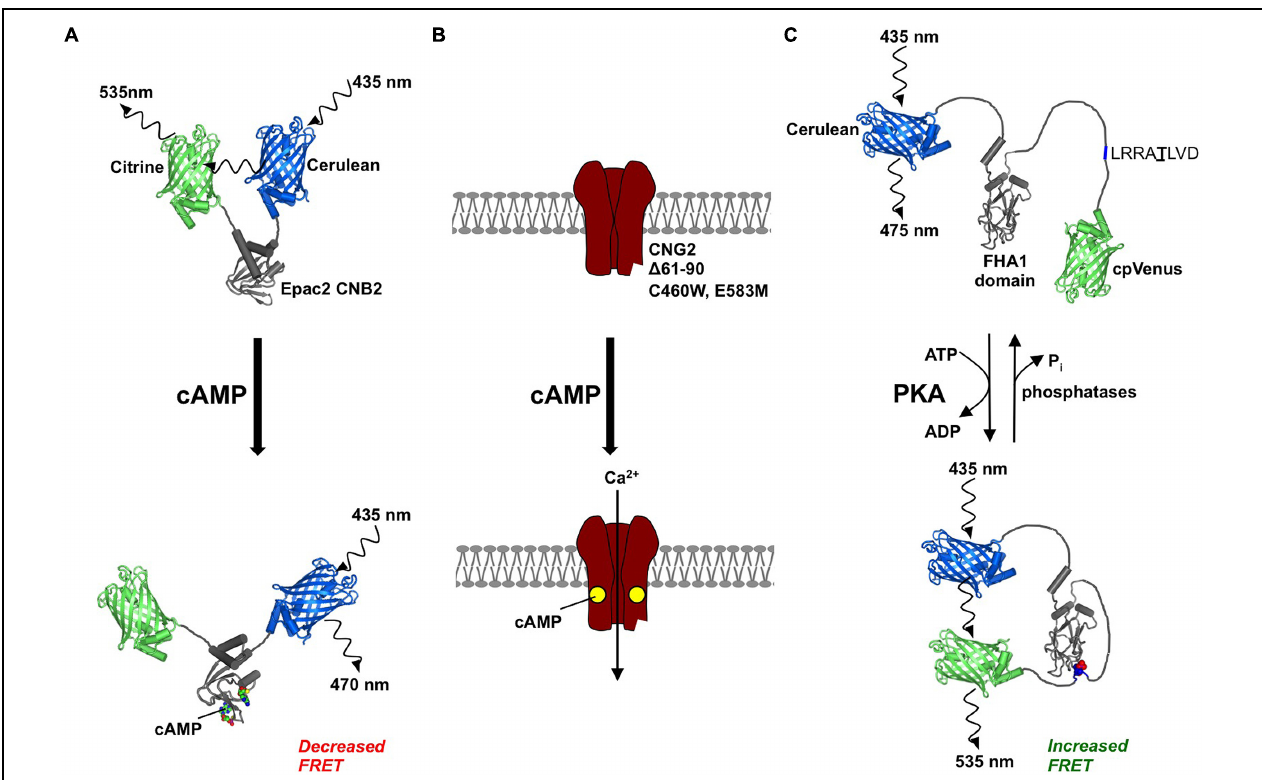
FIGURE 1 | Tools for monitoring cyclic AMP (cAMP) signaling. Two cAMP sensors and an A-kinase activity reporter are illustrated. (A) Cartoon showing mechanism for cAMP sensing by ‘Ci/C-Epac2-camps,’ which is based on the second cAMP binding domain of Epac2. Elevation of cAMP leads to separation of citrine and cerulean fluorescent proteins that can be detected as a decrease in FRET (B) cAMP sensor based on cyclic nucleotide-gated channel 2 (CNG2), which is modified with removal of residues 61–90 to prevent Ca 2 + /calmodulin